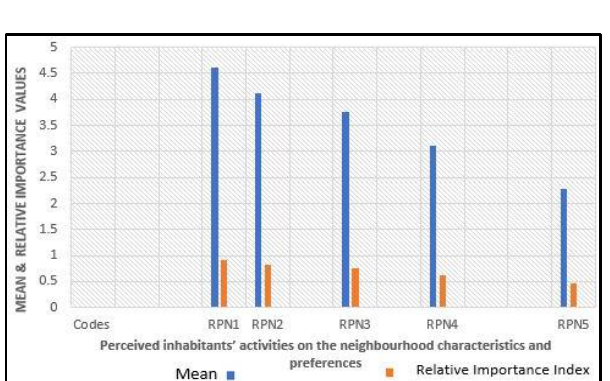
Figure 12. Perceived activities on the neighbourhood characteristics and preferences